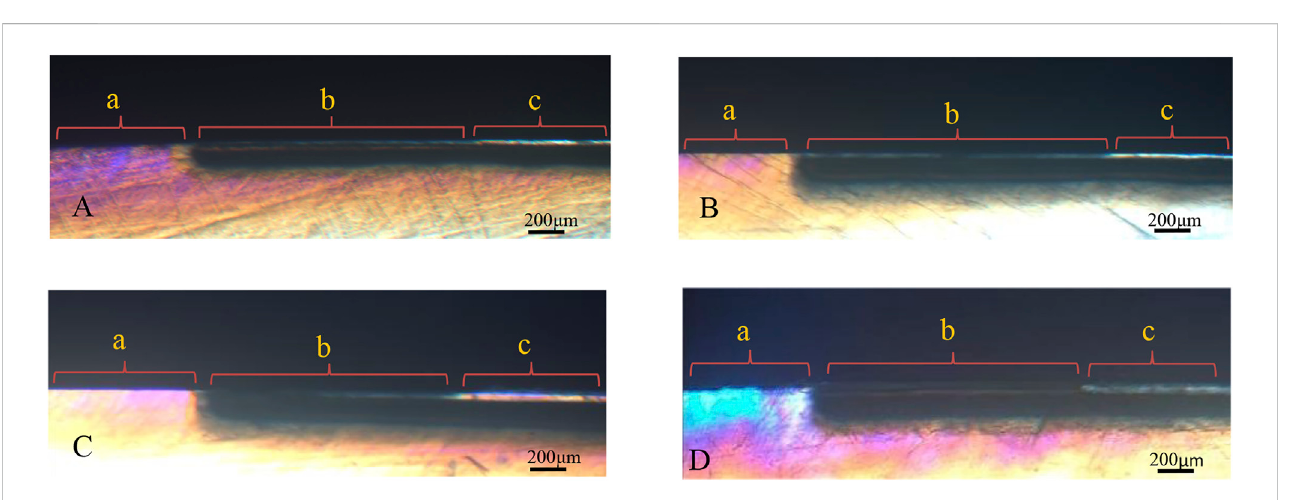
FIGURE 6 PLM pictures for the groups. (A) remineralizing medium group. (B) studied peptide 1 group. (C) studied peptide 2 group. (D) fl uoridate remineralizing medium